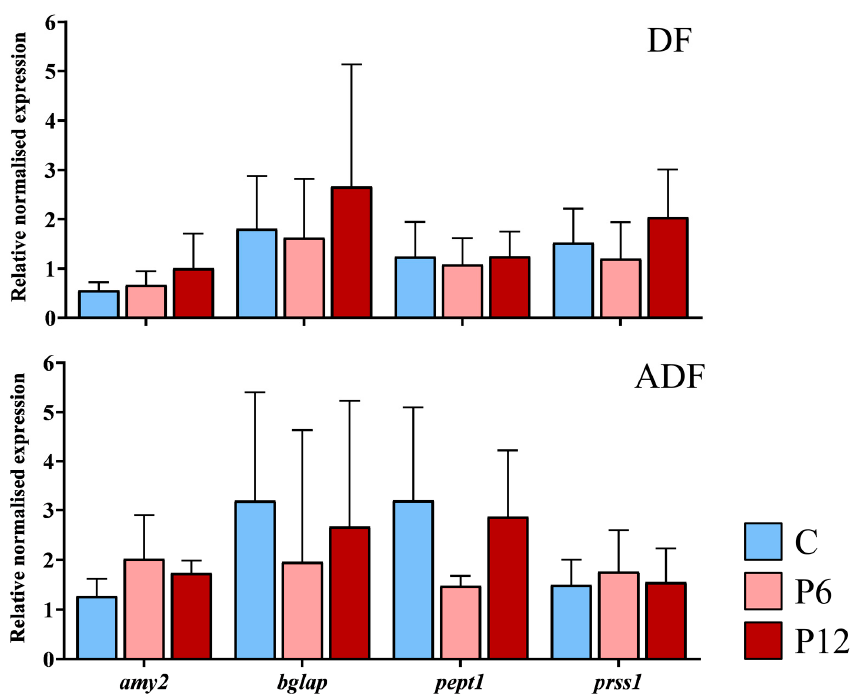
Figure 7. Relative expression of the amylase alpha 2a (amy2), osteocalcin (bglap), peptide transporter 1a (pept1) and trypsin (prss1) during the development (15 dpf) of the zebrafish larvae fed with the three experimental diets (C, P6, P12) according to the two regimes (DF, ADF). Values are presented as means ± SD. Statistically significant differences between the diets are indicated by the absence of a common letter ( n = 4–8 pooled samples of 5 individuals per diet and gene, p < 0.05). 3.6. Gene Expression after SCT Is Affected by the Diets and Feeding Regimes Regardless of the feeding regime, results highlighted that external phenotype (N~S) within each diet is not associated with any differential gene expression after the SCT ( p > 0.05, Supplementary Table S4). Expression levels of three genes were influenced by the experimental diets (C, P6, P12) in the two feeding regimes (DF, ADF). Spp1 transcript levels were significantly elevated in P12 diet (2.77 ± 1.42) in case of early diet provision (Figure 8, DF) compared with P6 (1.51 ± 0.70) but not compared with C (1.72 ± 0.51) diets. Ostn transcript levels also reached significantly higher levels in P12 (2.12 ± 0.57) compared with P6 (1.50 ± 0.41) but not C group (1.61 ± 0.41) under the same regime (Figure 8, DF). On the ADF regime (Figure 8, ADF), P6 presented the highest levels of spp1 (2.79 ± 1.76), being statistically different from the C (1.05 ± 0.26) but not the P12 group (2.08 ± 1.18). Simultaneously, tnni2 presented a significantly higher expression in the P12 group (1.68 ± 0.63) compared to the C but not the P6 (0.72 ± 0.37 and 1.47 ± 1.00 respectively, Figure 8, ADF)